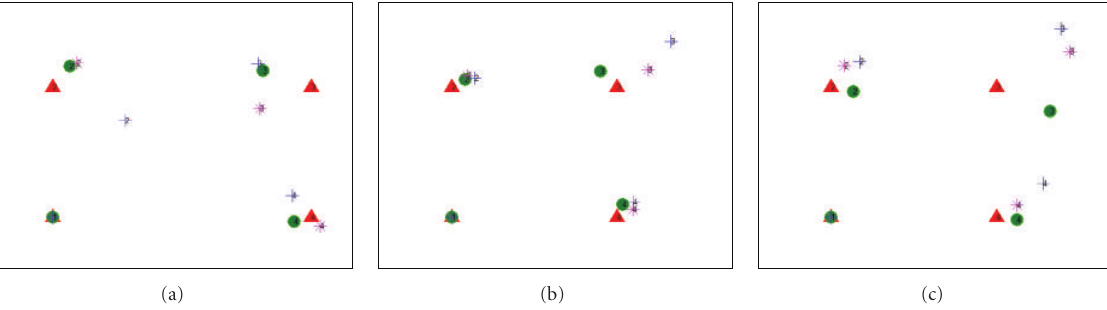
Figure 10: Performance comparison for camera localization using CLUTE ( green circle ), MAP ( magenta star ), and MDS ( blue cross ). The red triangles denote the ground-truth position of the cameras. (a) Experiment 1; (b) Experiment 2; (c) Experiment 3.